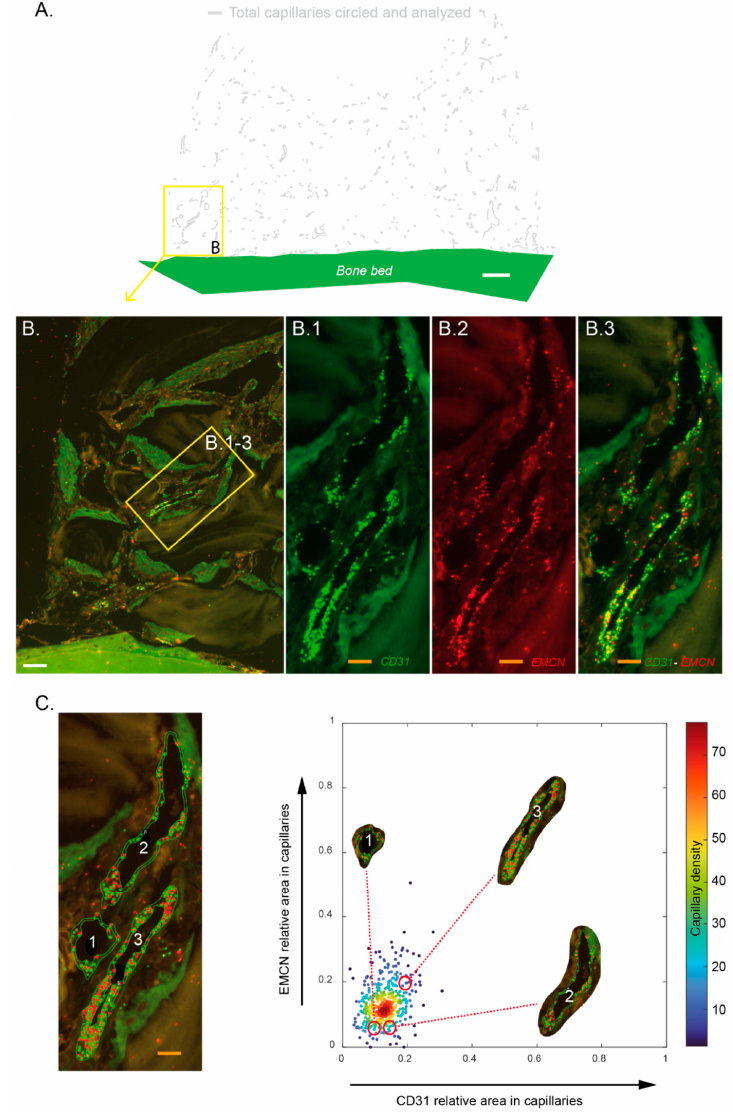
Figure 4. Assessment of the relative CD31 and EMCN expression in capillaries. Each sample (n = 6 at 2 and 4 weeks) was hybridized with specific probes targeting CD31 and Endomucin (EMCN) mRNA. Resulting slides were entirely scanned by using a fluorescent microscope. Based on morphology and CD31 staining, the whole capillaries were circled and the relative areas of CD31 dots